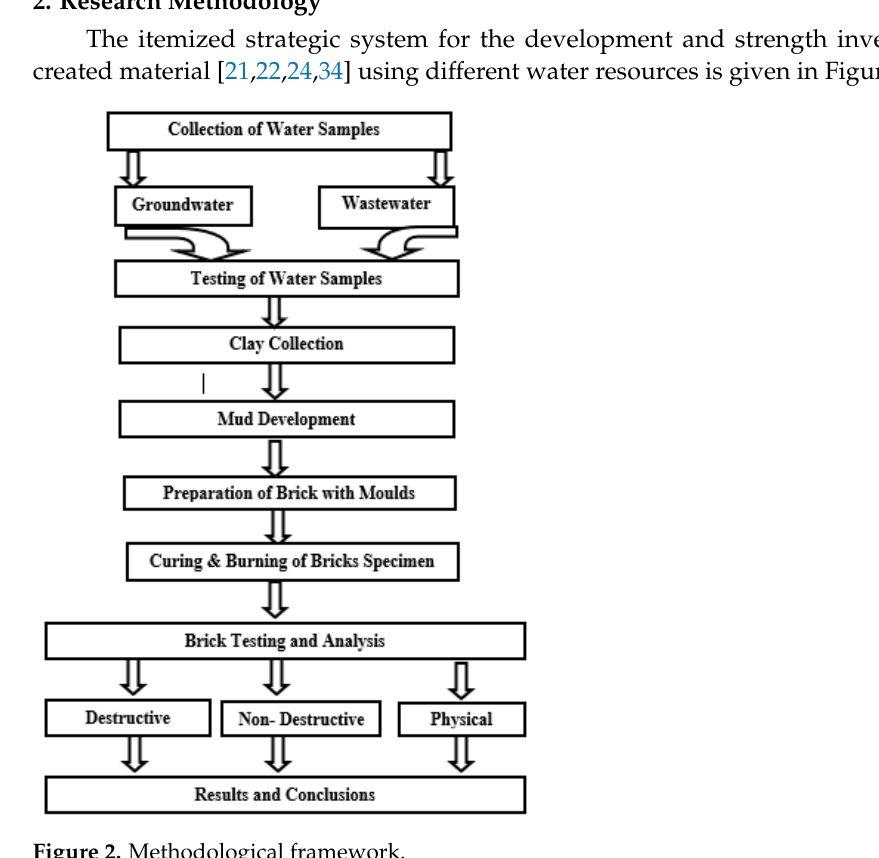
Figure 2. Methodological framework.